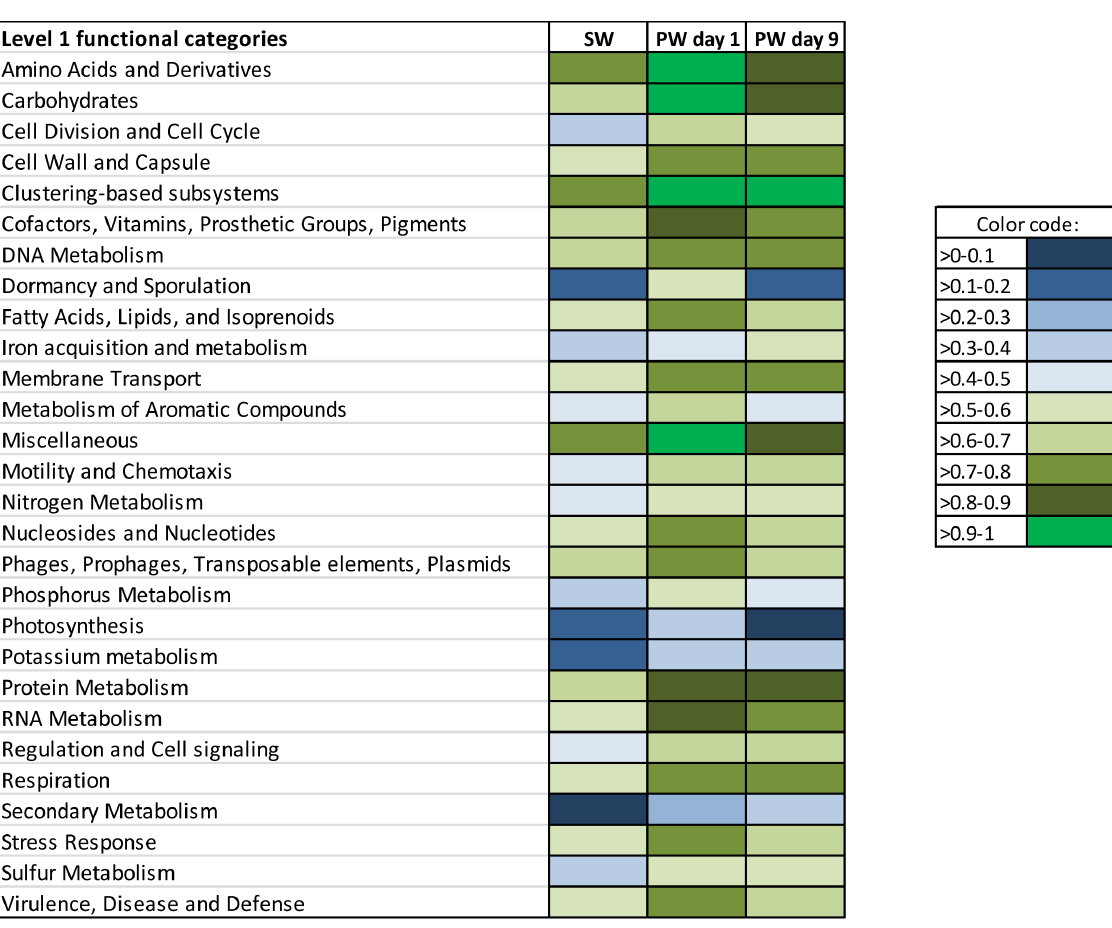
Figure 6. Normalized abundance (values of 0–1) of contigs belonging to Level 1 functional categories in source water (SW), produced water day 1 (PW day 1) and produced water day 9 (PW day 9). Functional annotations were assigned based on the Subsystems database.